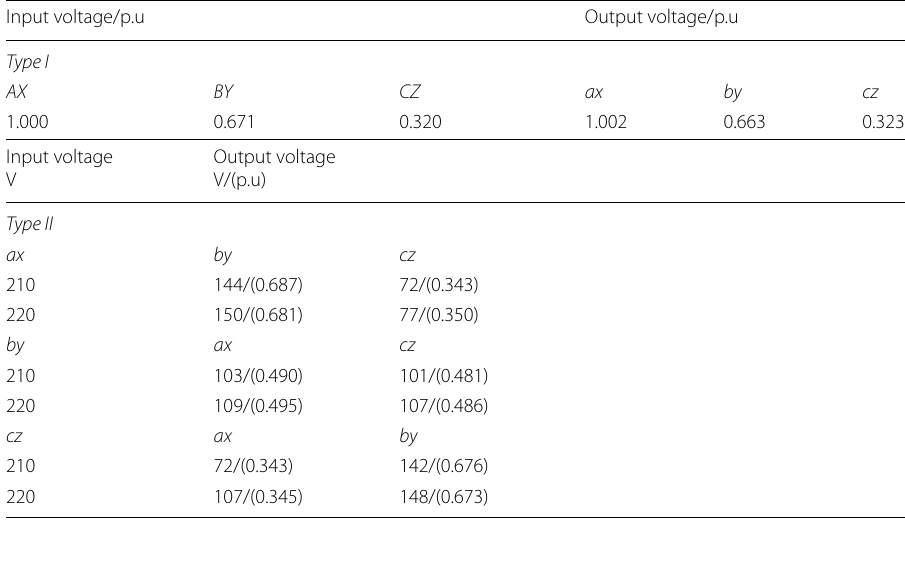
Table 1 Tests in some three-phase three-limb transformers Input voltage/p.u